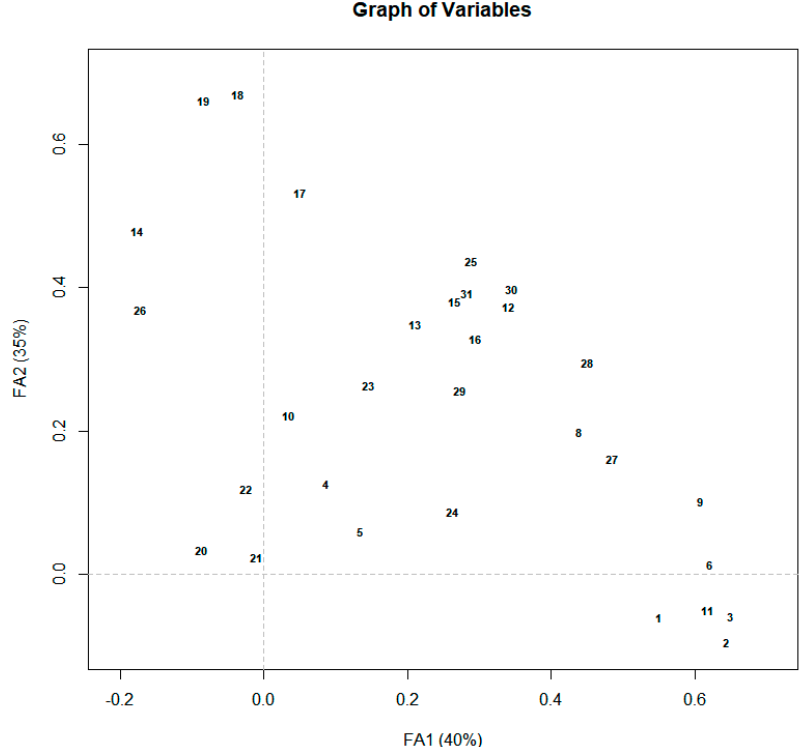
Figure 1. Projection of main variables/questions about consumers’ perceptions of intrinsic and intrinsic attributes and consumers buying/consumption motivations in the FA1 and FA2